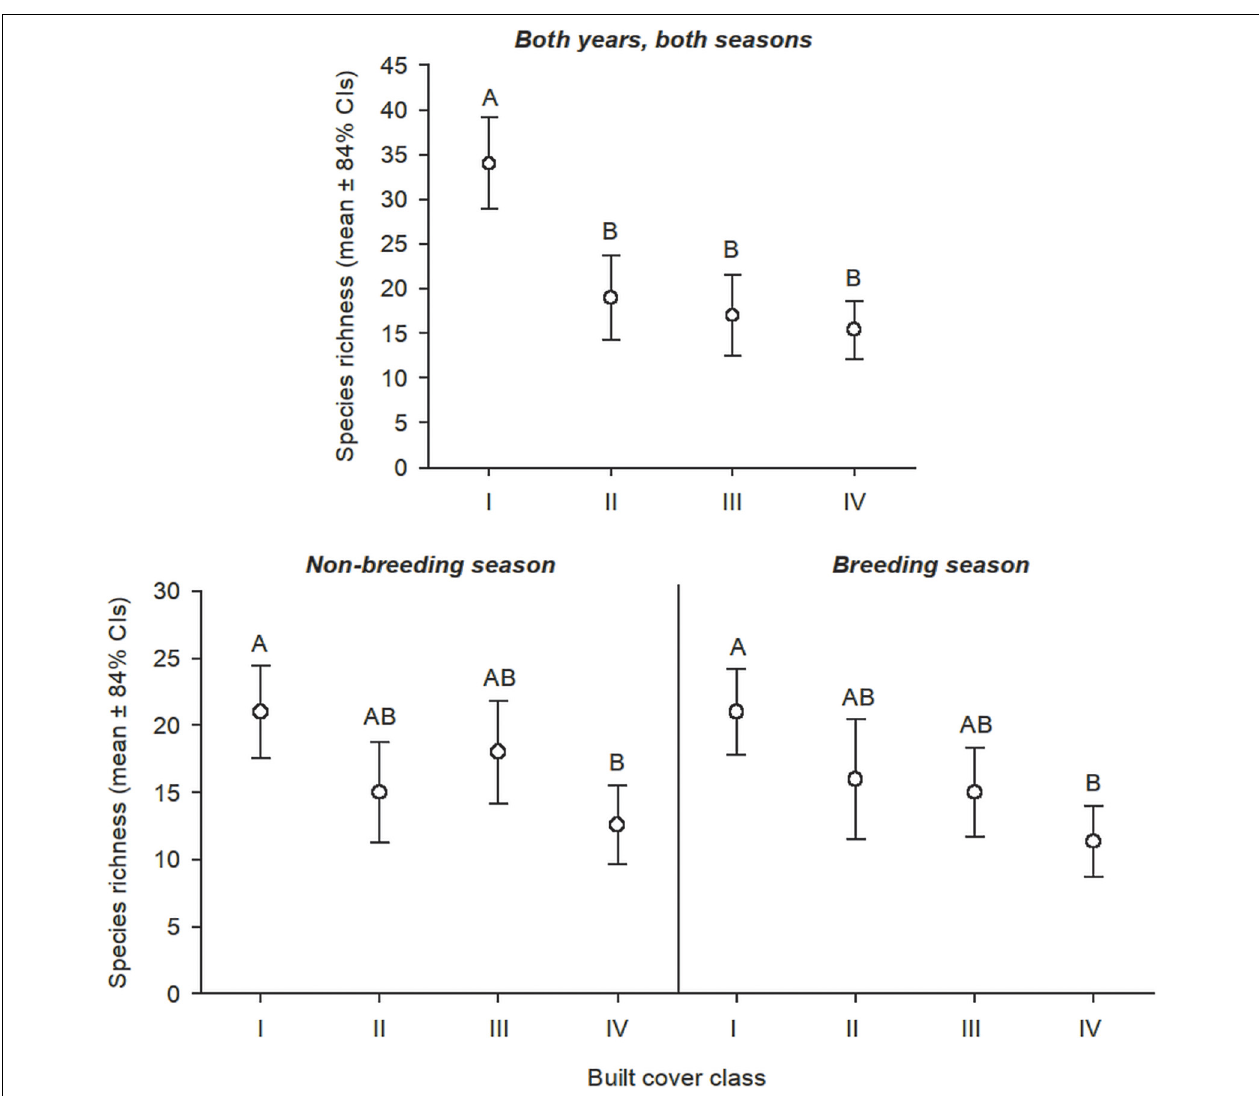
FIGURE 3 | Species richness contrasts among four built cover classes of the city of Xalapa. Class I = 0–25% built cover, Class II = 26–50% built cover, Class III = 51–75% built cover, Class IV = 76–100% built cover. Letters above CI whiskers represent statistical differences based on overlapping 84% CIs.